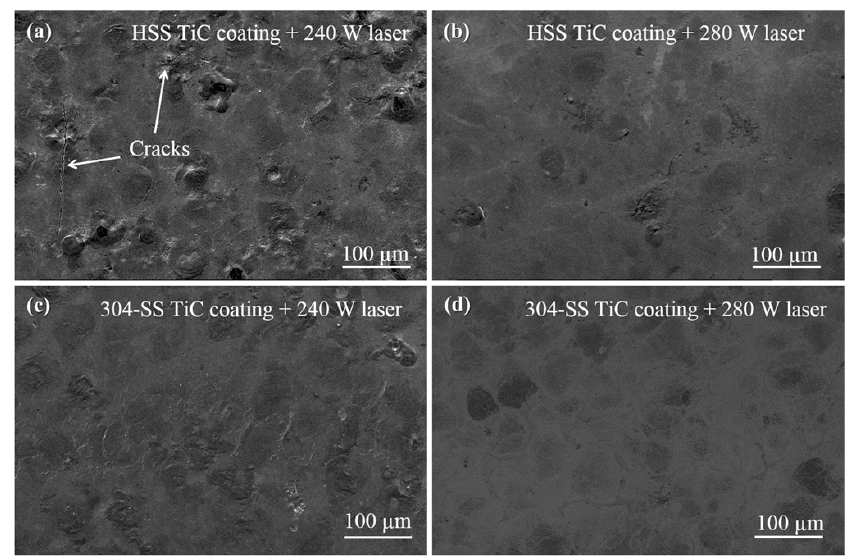
chined surface; and ED-coated TiC/Fe cermet) [7].